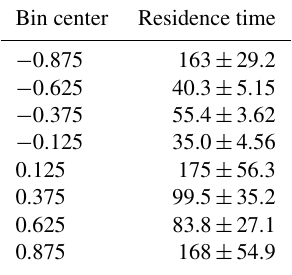
Table 1. Average residence time and standard errors, in units of days, for each bin of QBO i . Only the four full cycles of the QBO in our data are analyzed